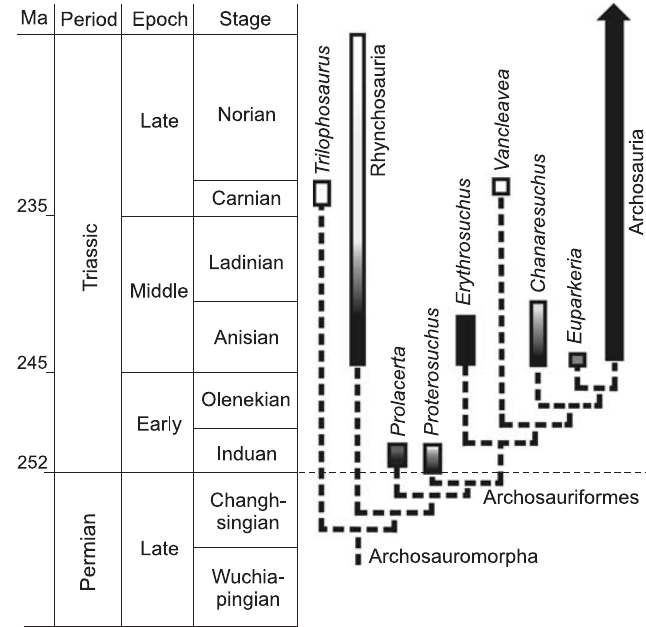
3. Stratocladogram of archosauromorph bone histology modified from Botha-Brink and Smith (2011) with the new data from the present study. Lamellar-zonal and parallel-fibred bone indicates slowest growth, represented by white and grey shading, respectively. Black shading in- dicates rapid growing of fibrollamelar bone. In the Rhynchosauria it oc- curs during the early ontogenetic stages, similarly to Proterosuchus and Chanaresuchus . Phylogeny from Sues (2003), Dilkes and Sues (2009), and Nesbitt et al. (2009). Histological information from Ricqlès et al. (2008), Nesbitt et al. (2009), Werning and Irmis (2010), and Botha-Brink and Smith (2011). Time scale from Walker and Geissman